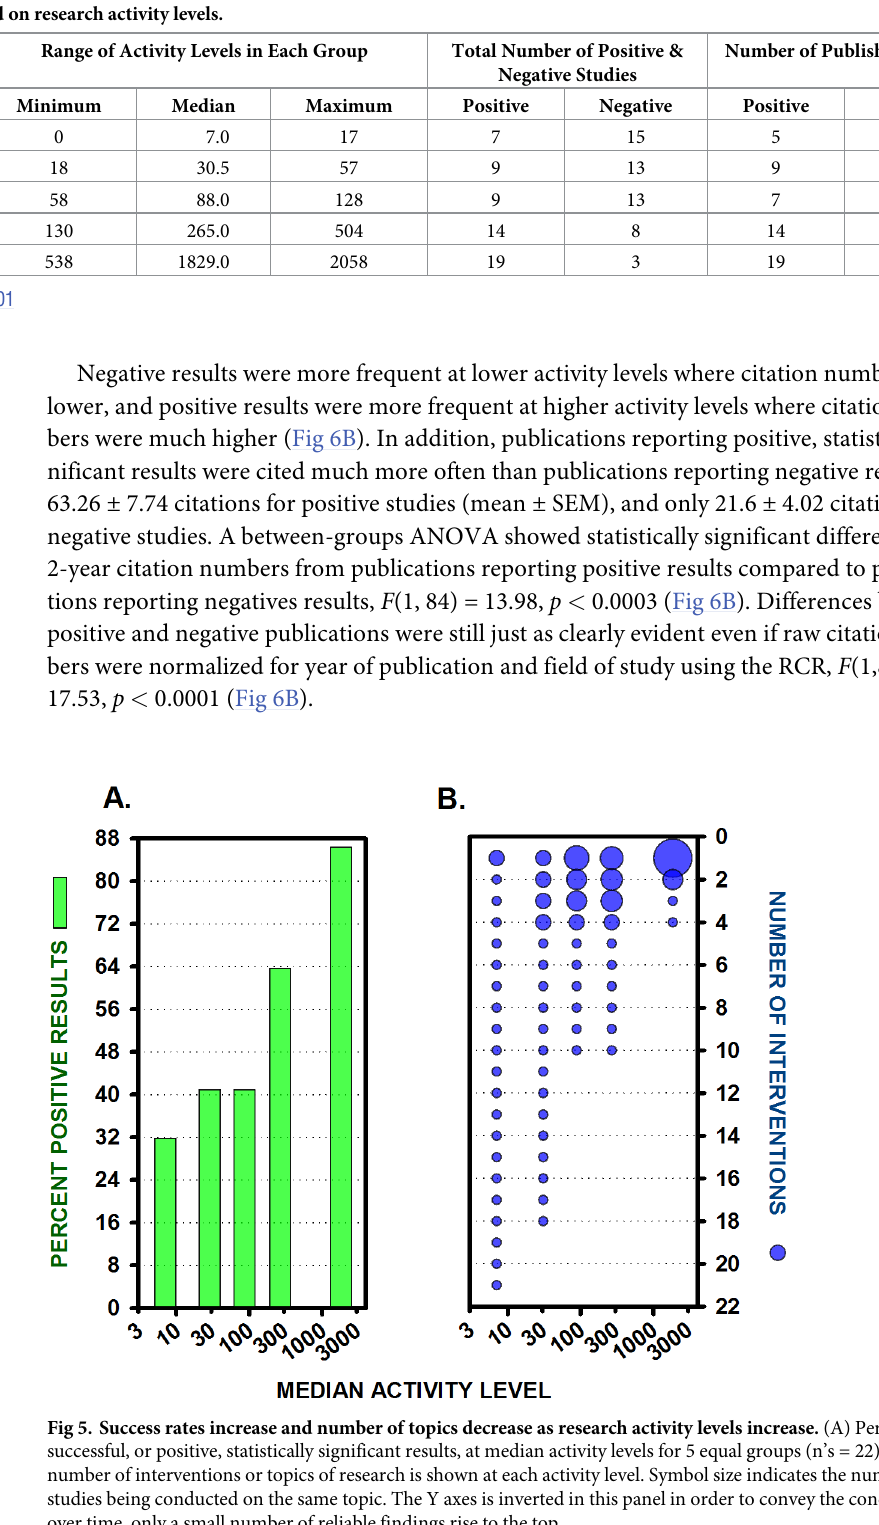
Table 1. Studies divided into 5 groups based on research activity levels.